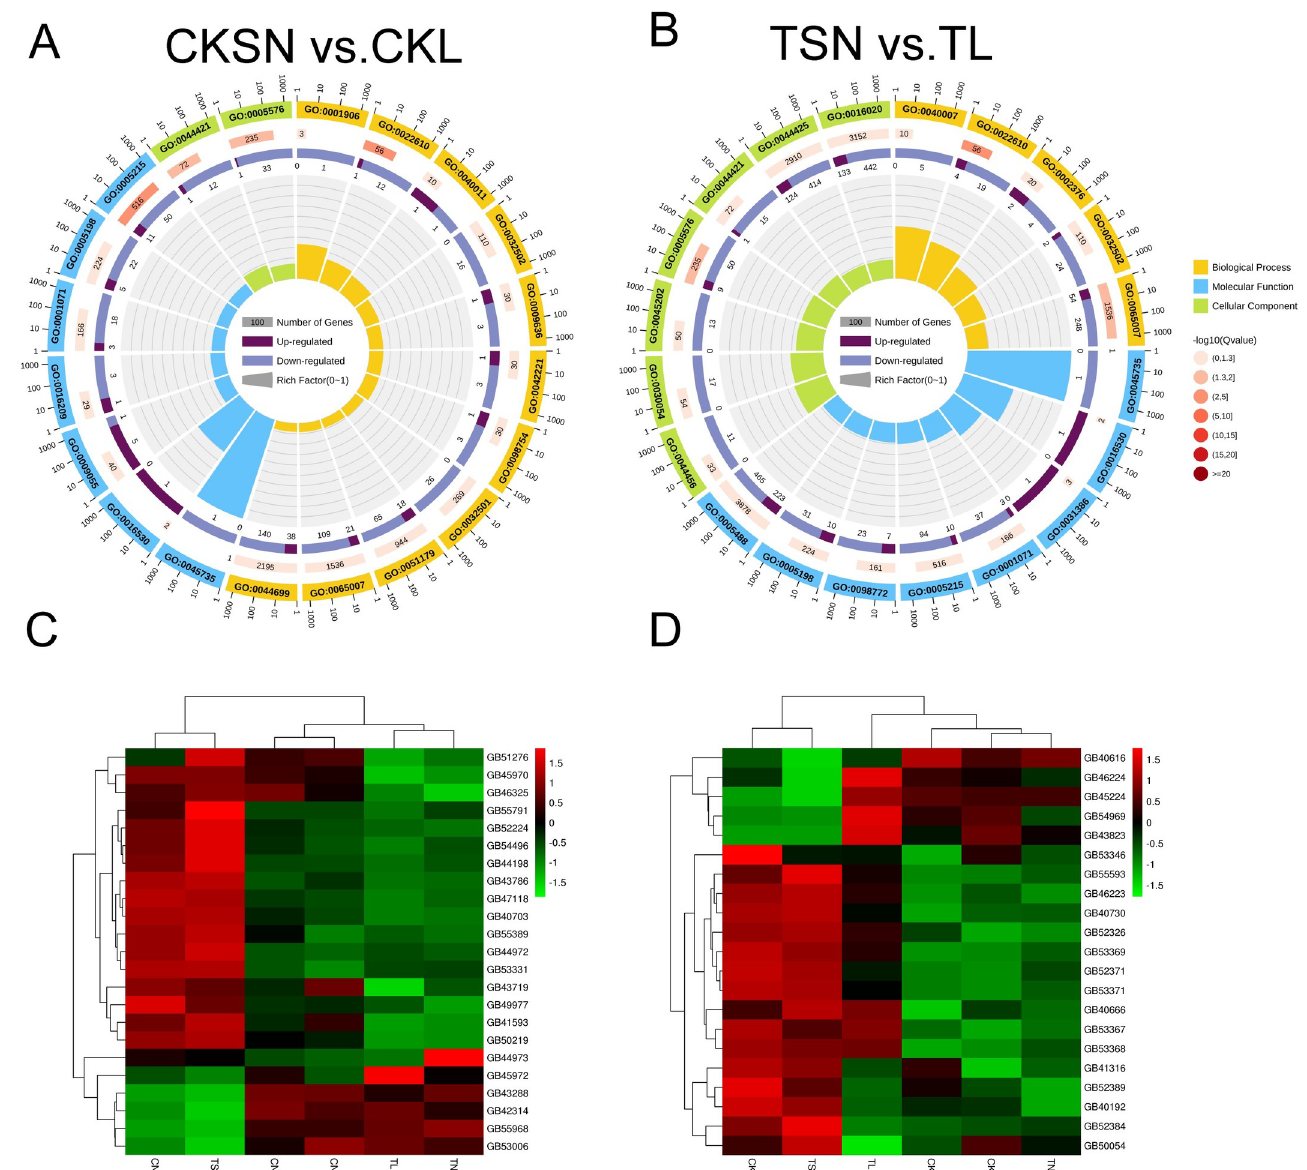
Fig 6. The differentially expressed genes (DEGs) between bees with or without learning ability in CK group and T . mercedesae -treated group. A&B , GO term enrichment analysis in CKSN/CKL and TSN/TL was performed. The first lap indicates top 20 GO term and the number of the genes corresponds to the outer lap. The second lap indicates the number of the genes in the genome background and Q values for enrichment of the DEGs for the specified biological process. The third lap indicates the ratio of the upregulated genes (deep purple) and downregulated genes (light purple). The fourth lap indicates the enrichment factor of each GO term. C. Heatmap of related transcripts identified in the comparison between bees with or without learning ability. D. Heatmap of chemosensory-related transcripts identified in the comparison between bees with or without learning ability. The colours indicate the log2-transformed expression values, which represent the expression level of a transcript identified in control group or infested